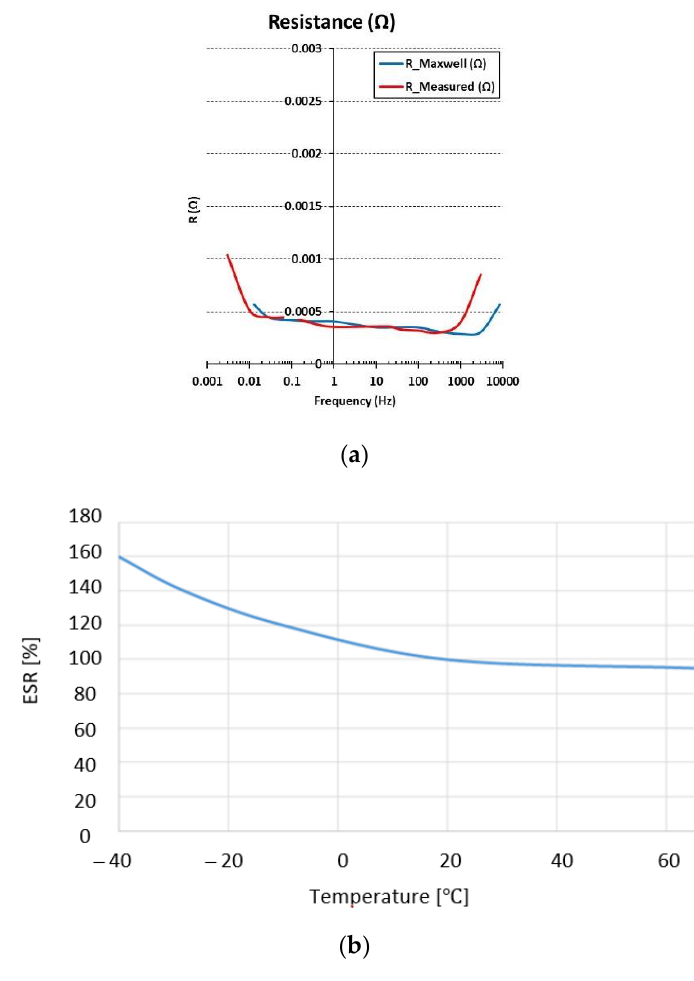
Figure 3. ( a ) ESR variation respect to the voltage, adapted from [7]; ( b ) ESR variation as a function of the frequency.